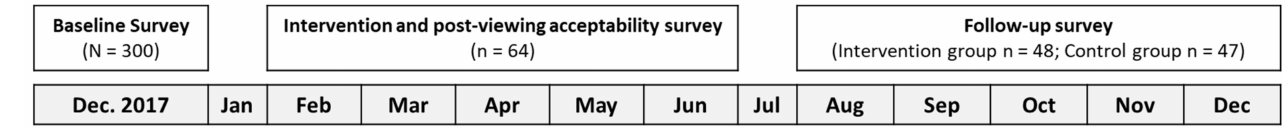
Figure 3. Timeline of the evaluation of “Bondage: It is better to know”